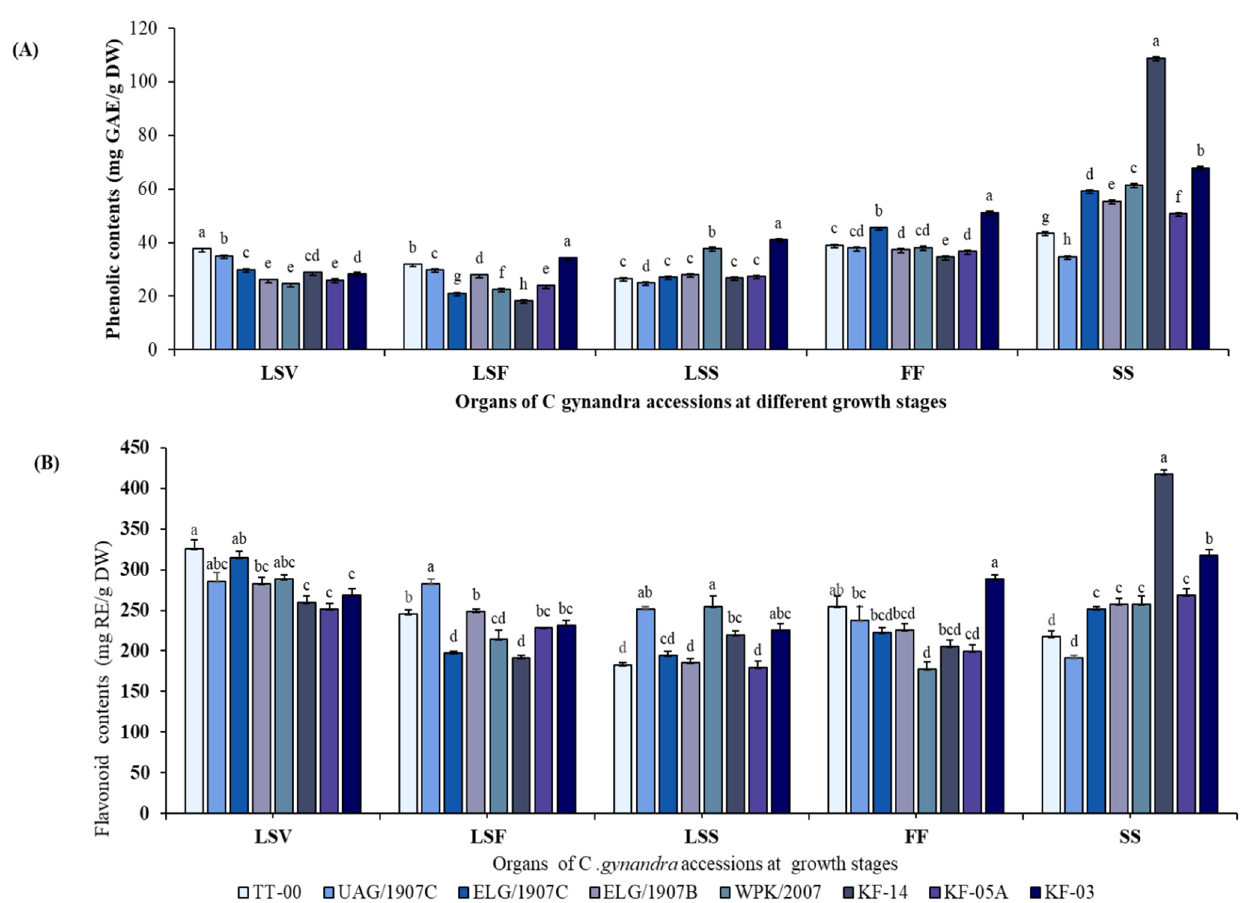
Figure 1. Changes in total phenolic content in mg GAE/g DW ( A ) and total flavonoid content mg RE/g DW ( B ) in the different organs of eight CG accessions during growth. Column and error bars represent the means and standard deviation ( n = 3). Columns with different letters for each specific organ are significantly different ( p < 0.05). mg GAE/g DW = milligram gallic acid equivalent per gram of dry weight; mg RE/g DW = milligram rutin equivalent per gram of dry weight; LSV = leaves and stem in the vegetative stage; LSF = leaves and stem in the flowering stage; LSS = leaves and stem in the seed set stage; FF = flower in the flowering stage; SS = silique in seed set stage.